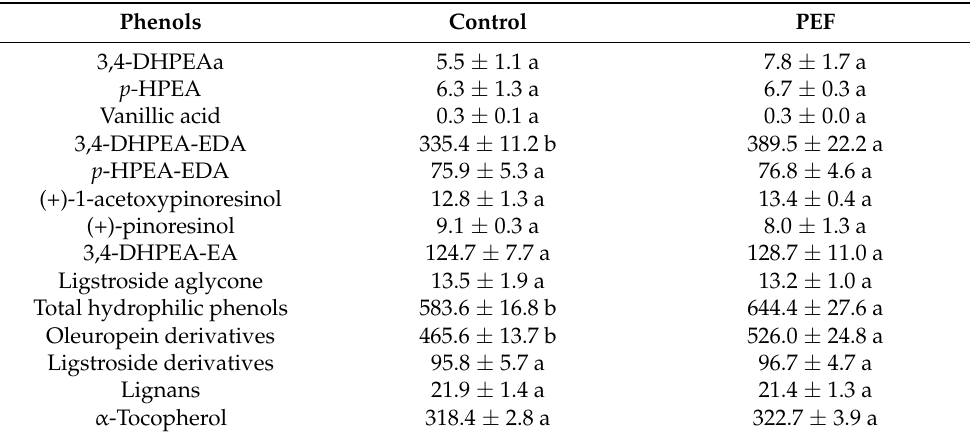
Table 4. Phenolic composition of EVOOs. Data expressed as mg kg − 1 . Phenols Control